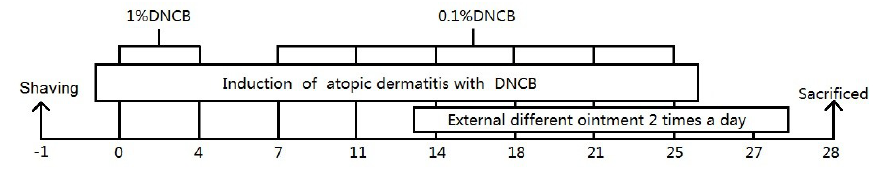
Figure 7. Schematic diagram of atopic dermatitis (AD) model establishment and